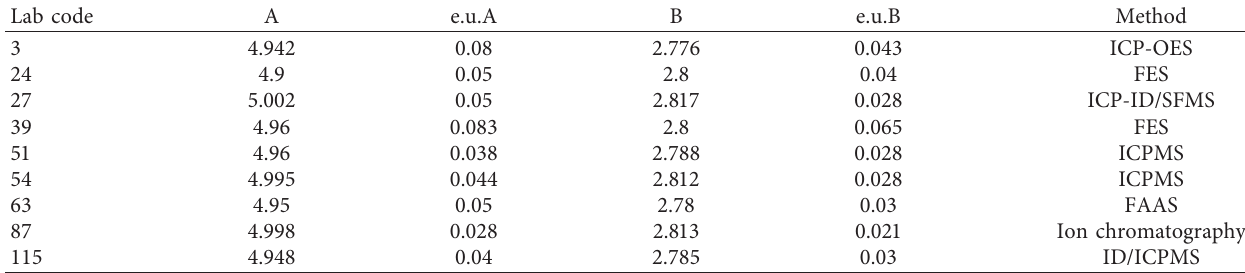
Table 4: The data obtained from RELA 2018.